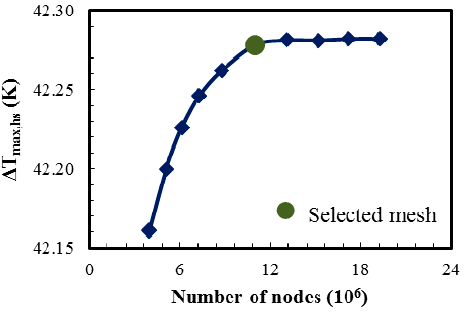
Figure 4. Grid independency test (PF design with single hotspot at the center at a total flow rate of 0.006 kg/s).